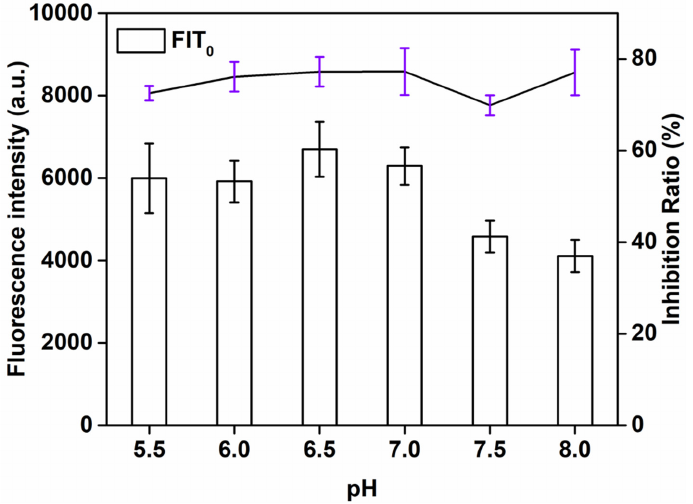
Figure 2. Optimization detection conditions of QBs-LFIA. Effects of pH value.